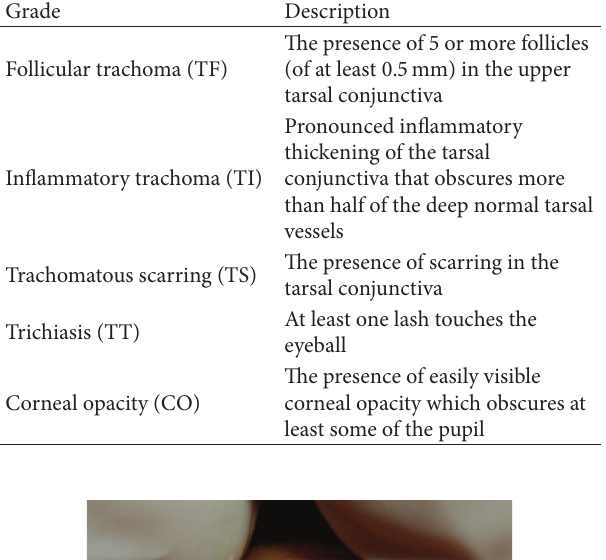
Table 1: World Health Organization simplified classification of trachoma infection.